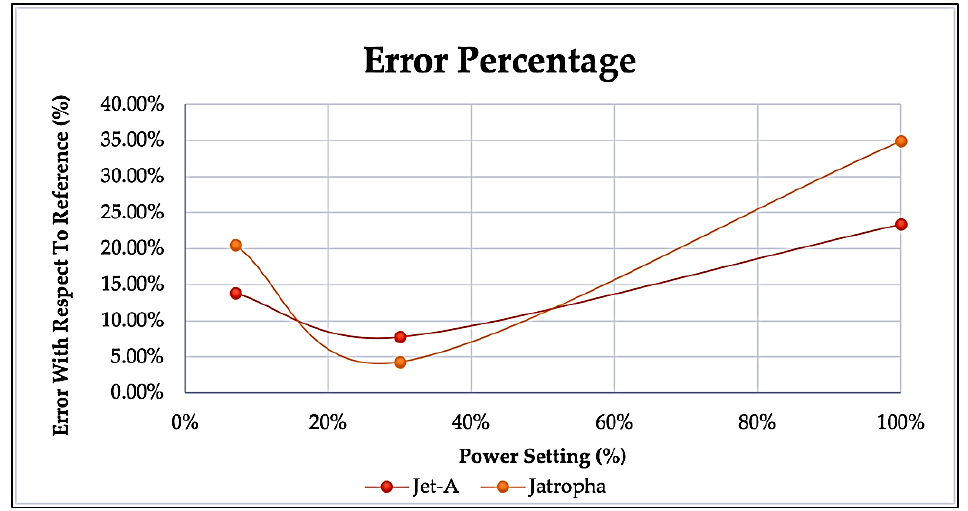
Figure 6. Error percentage with respect to the reference results of Olivera and Brojo [38].